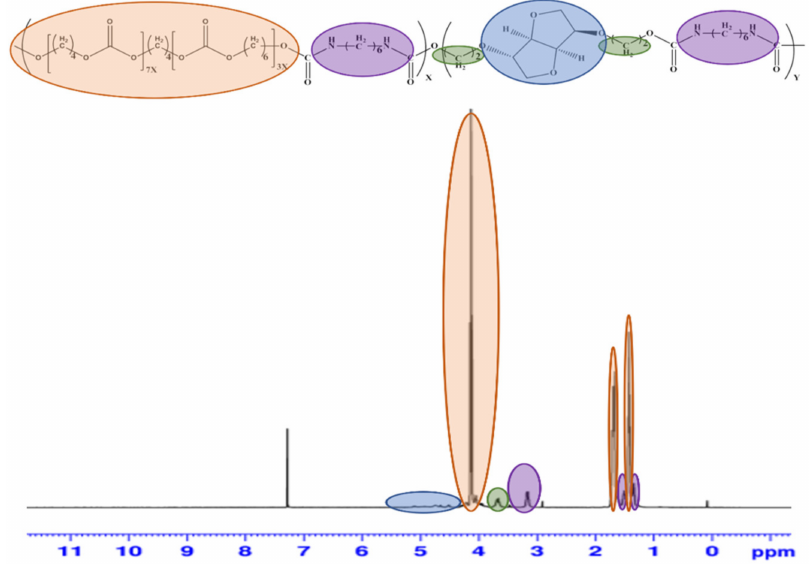
Figure 4. 1 H-NMR spectrum of